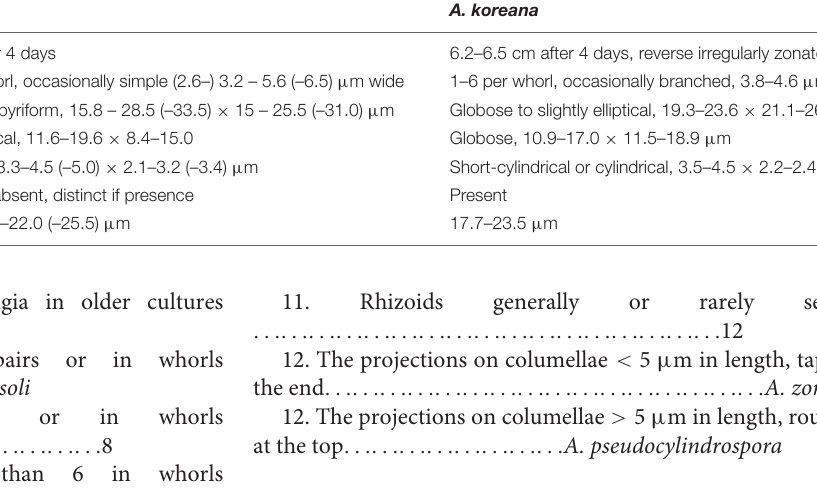
FIGURE 11 | Colonies of Absidia zonata CGMCC 3.16033 at 27 ◦ C after 8 days on MEA (A) obverse, (B) reverse; on SMA (C) obverse, (D) reverse; after 7 days on PDA (E) obverse, and (F) reverse. TABLE 2 | Comparisons of morphological characteristics of Absidia zonata and Absidia koreana on SMA media at 25 ◦ C.